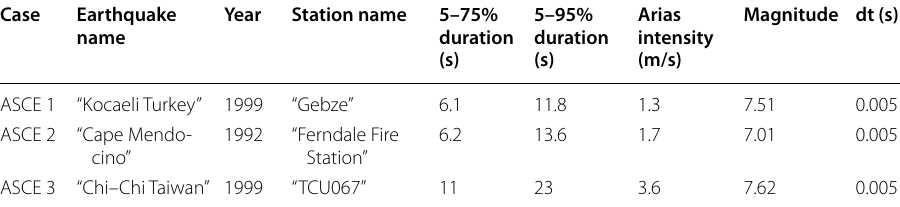
Table 2 Seismic records used in the dynamic